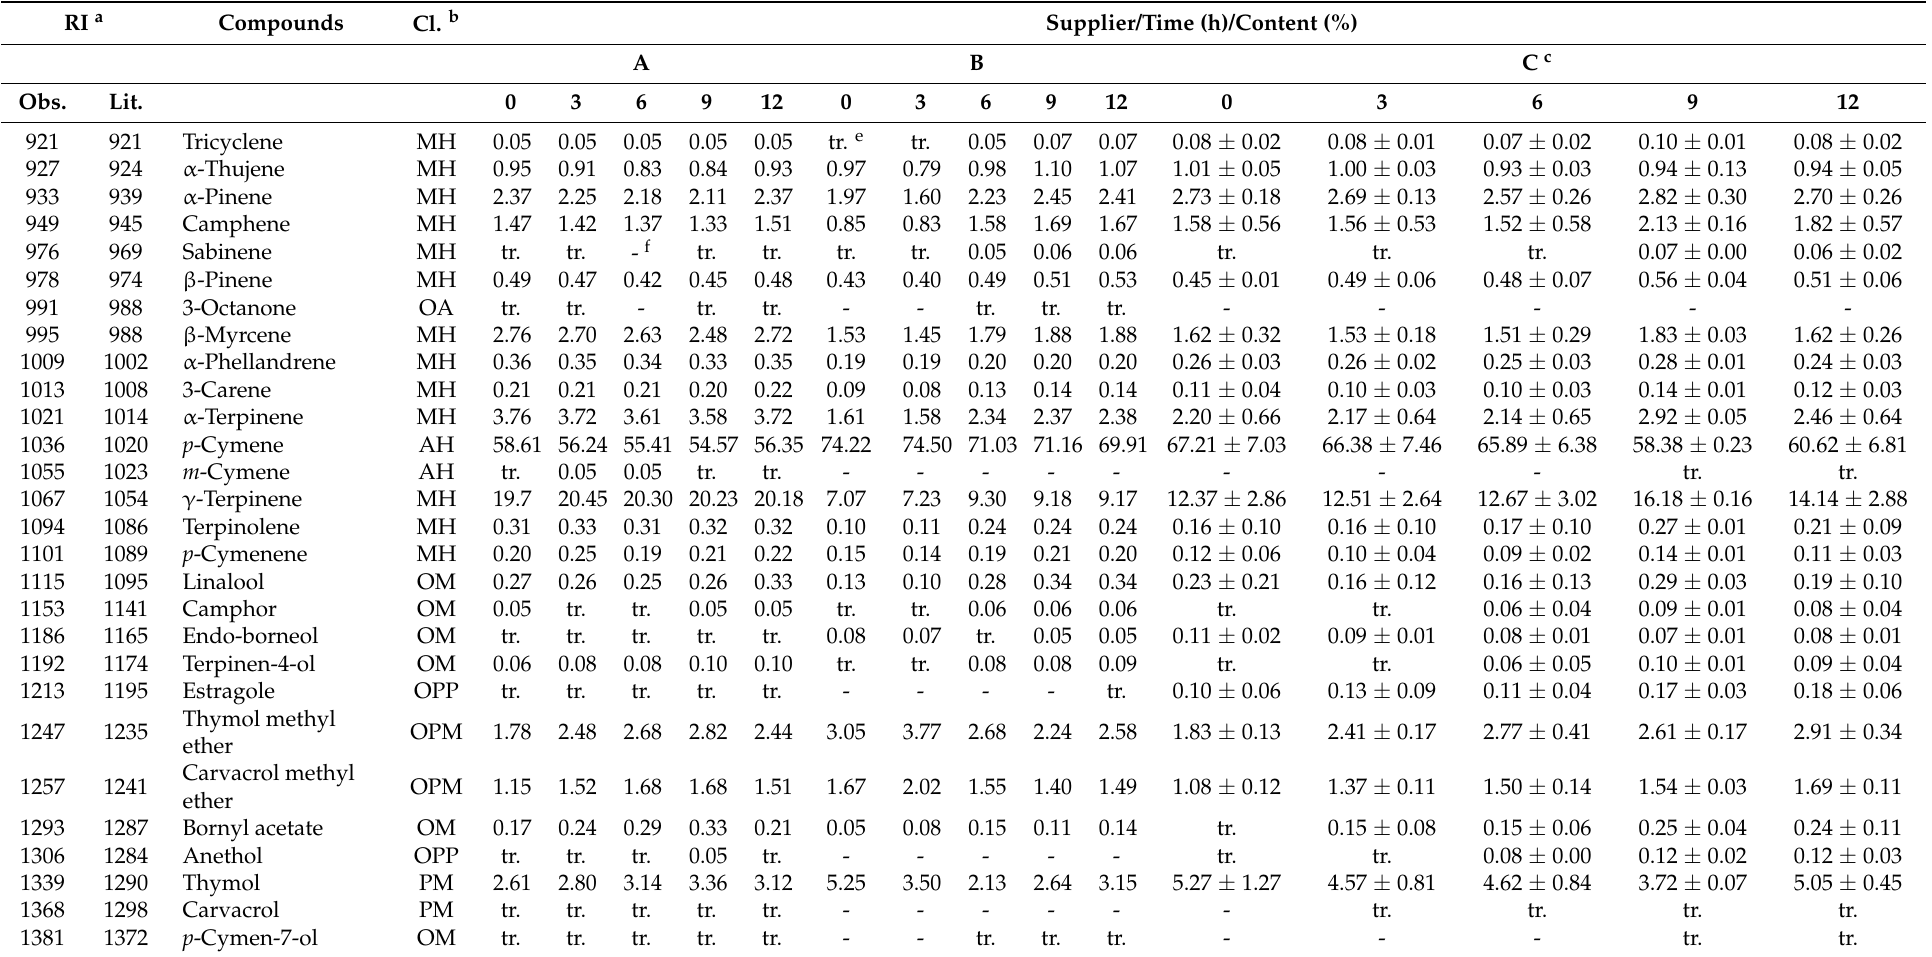
Table 3. Chemical composition of the headspace above a mixture of Mueller–Hinton broth and Thymus vulgaris L. essential oils at a concentration of 512 µ g/mL over a 12-h period using solid-phase microextraction sampling technique. RI a Compounds